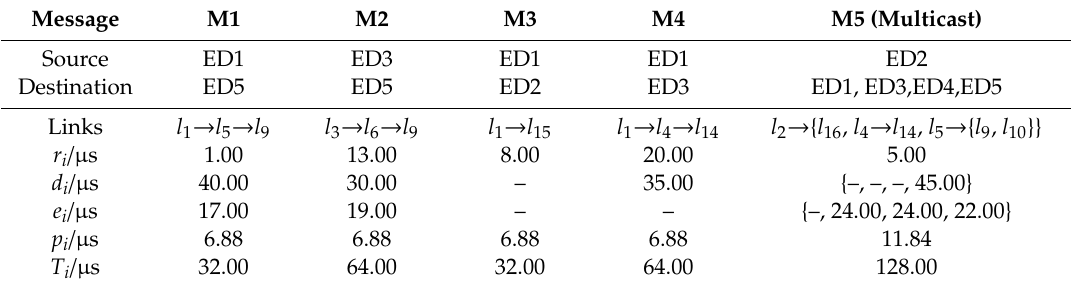
Table 1. Tasks and temporal constraints of periodic messages. ED: end